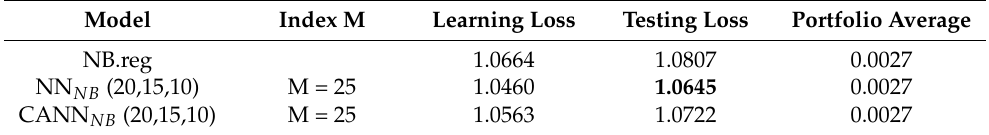
Table 11. Average of testing loss, learning loss, and portfolio average of regression and network-based models under negative binomial distributional assumptions from the 10 different folds. Model Index M Learning Loss Testing Loss Portfolio Average NB.reg 1.0664 1.0807 0.0027 NN NB (20,15,10) M = 25 1.0460 1.0645 0.0027 CANN NB (20,15,10) M = 25 1.0563 1.0722